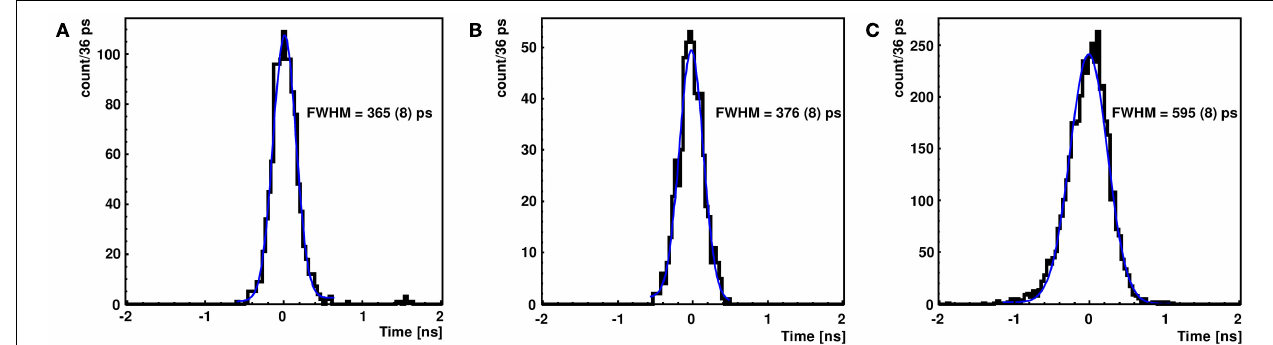
FIGURE 5 | Time coincidence peak of two simultaneously emitted photons from 60 Co measured by two identical plastic detectors (BC418) (A) and by a reflectively (B) as well as an absorptively (C) wrapped LaBr 3 :Ce detector measured against the reference plastic detector . The blue curve represents a Gaussian fit used to derive the indicated FWHM values.